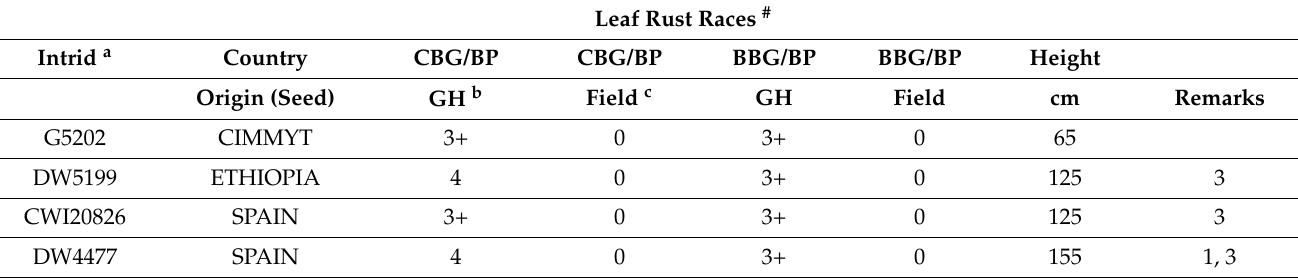
Table 3. Infection types at seedling, final disease severity in the field in response to two leaf rust races, and plant height of selected seedling susceptible adult plant resistant tetraploid accessions. Leaf Rust Races